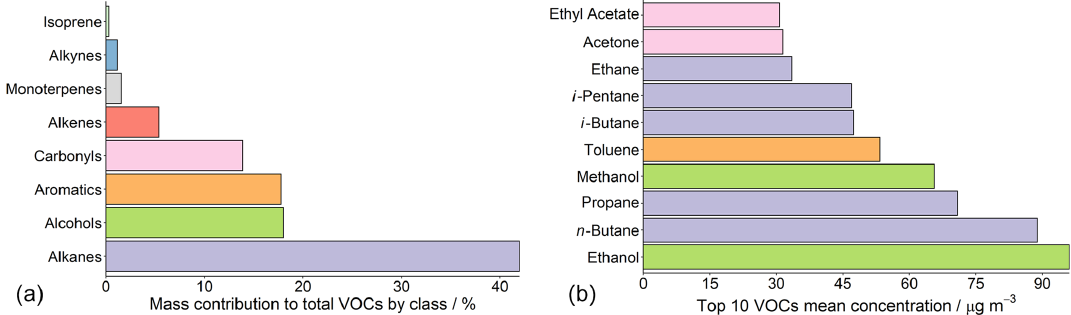
Figure 5. Percentage contribution of different VOC classes to the total mean measured NMVOCs (a) and the mean concentrations of the top 10 contributors to total measured VOC concentrations (b) during the campaign in µgm − 3 . Colours correspond to the different VOC classes.